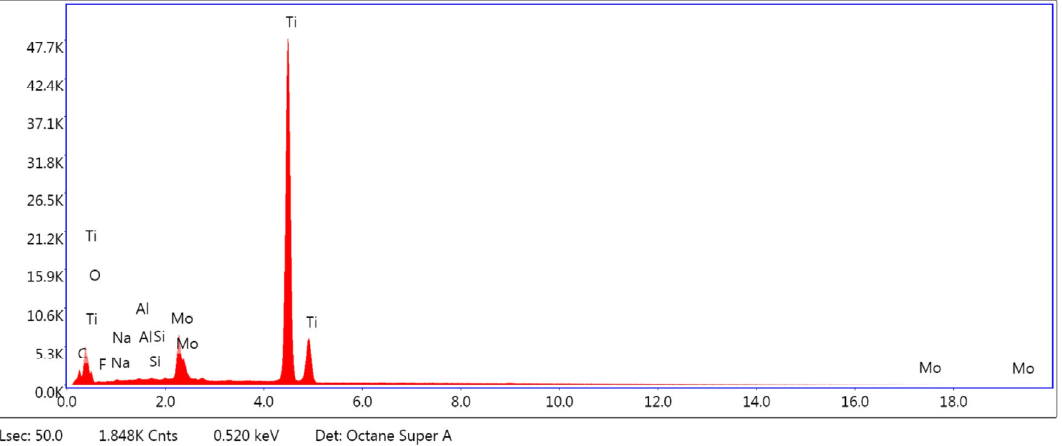
Figure 16 . The energy ‐ dispersive X ‐ ray spectrum results of the femoral CM nail made of Ti ‐ 15Mo Figure 16. The energy-dispersive X-ray spectrum results of the femoral CM nail made of Ti-15Mo titanium alloy in alpha plus beta annealed condition. titanium alloy in alpha plus beta annealed condition.